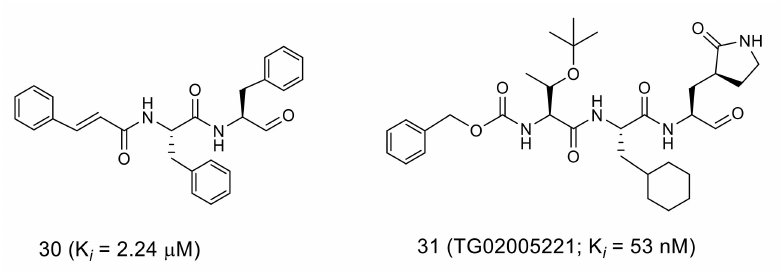
Figure 10. Structures of peptide aldehydes 30 and 31 .